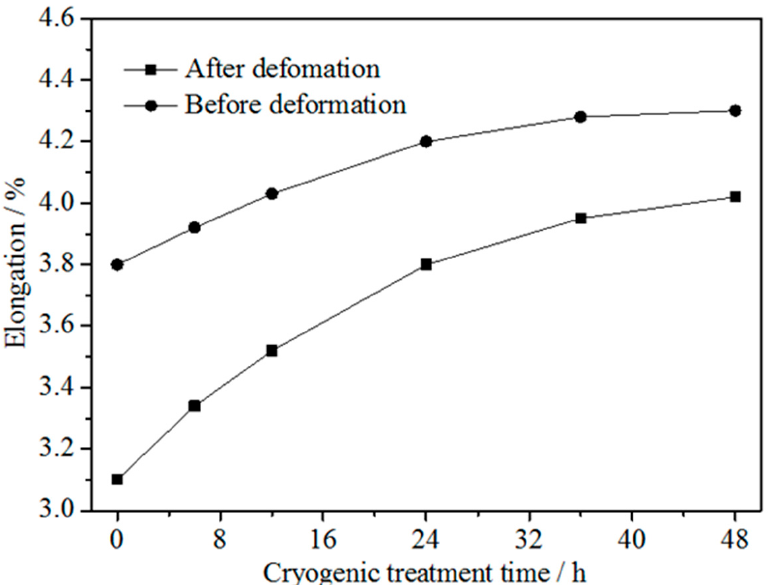
Figure 3. Elongation to fracture of the Cu-1.34Ni-1.02Co-0.61Si alloy before and after cold rolling at 47% reduction with the DCT time in liquid nitrogen.